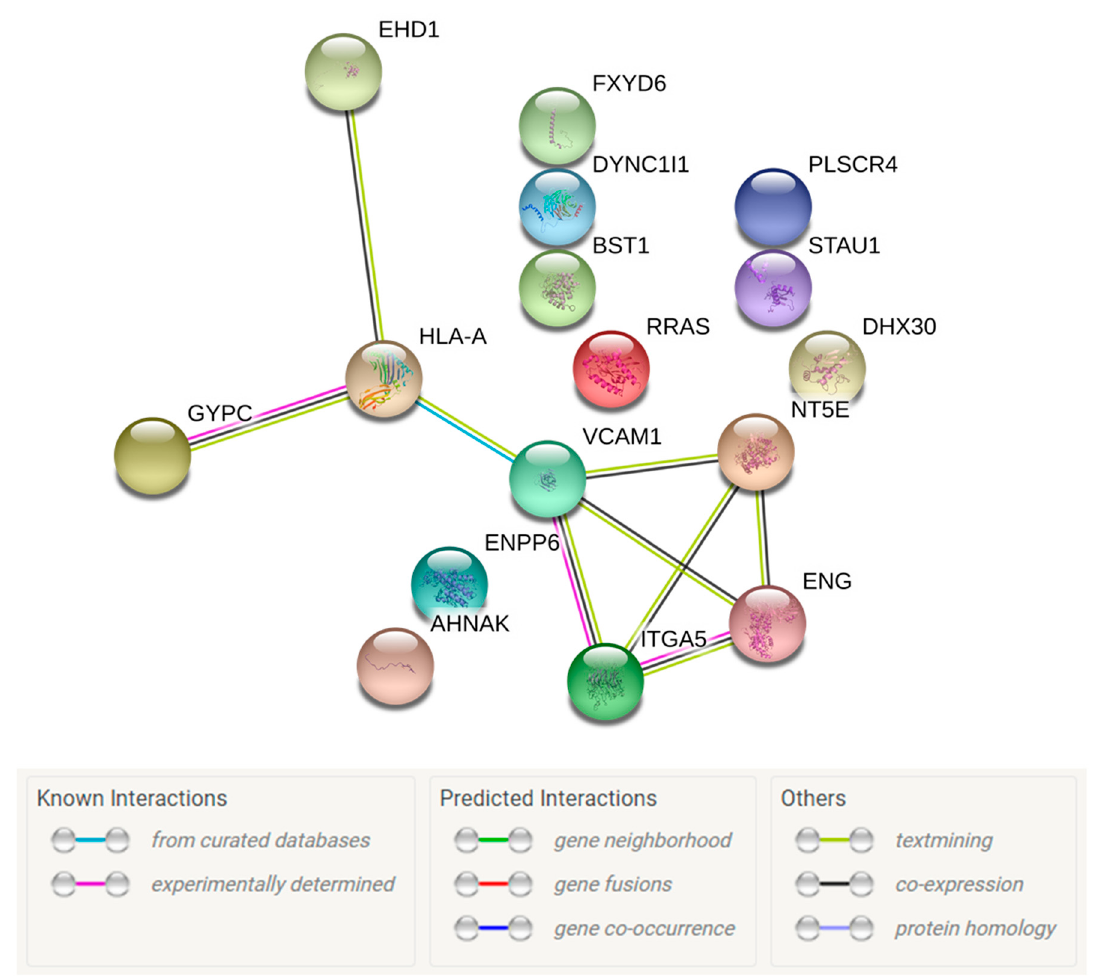
Figure 4. Search tool for the retrieval of interacting genes/proteins (STRING) analysis of the 16 proteins found to be differentially packaged in ALS MCEVs compared to NC MCEVs. Several deregulated ALS MCEV proteins appear to exhibit network relationships/connectivity. It appears GYPC and HLA-A, HLA-A and VCAM-1, VCAM-1 and ITGA5, and ITGA5 and ENG are known protein interacting partners. Graphs were created using STRING [47,48].